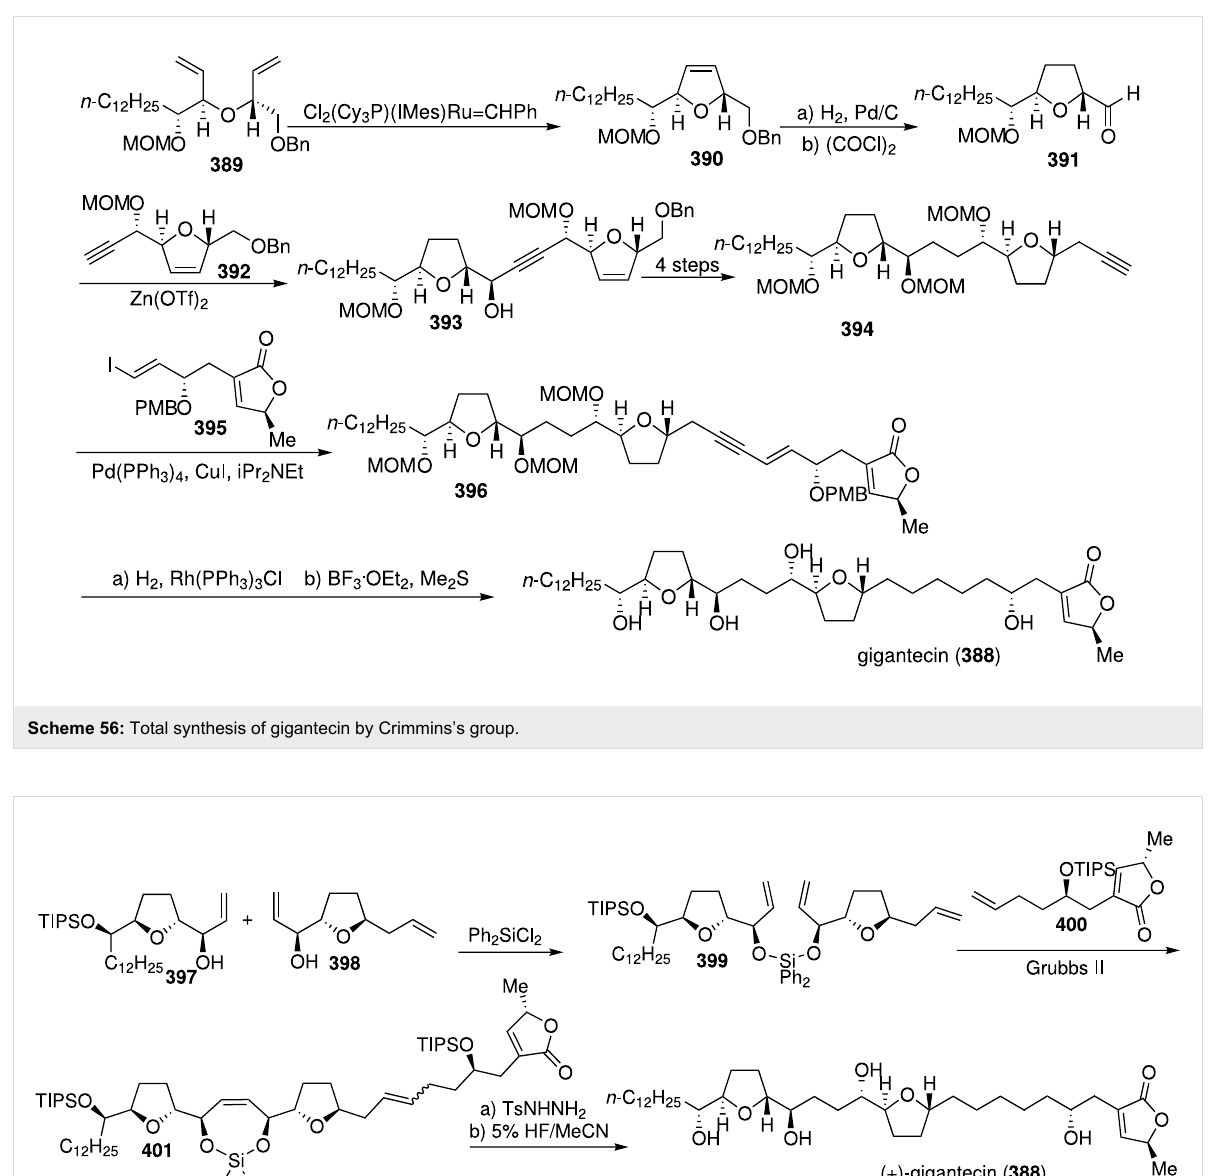
Scheme 57: Total synthesis of gigantecin by Hoye’s group.